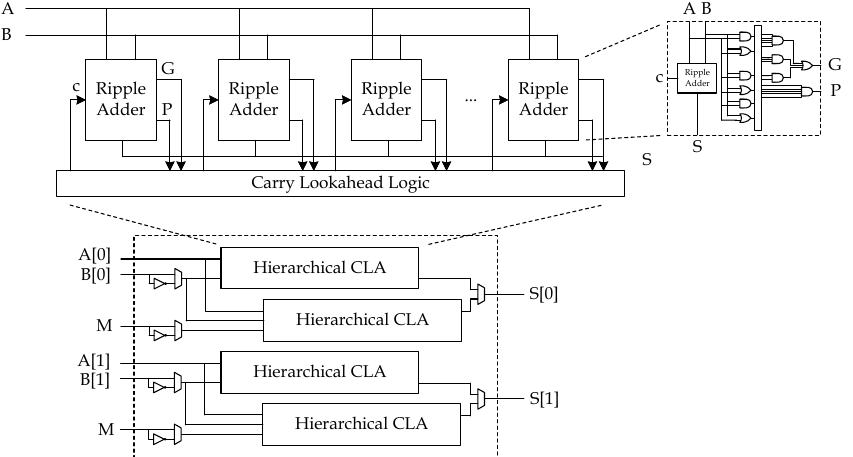
Figure 6. Schematic of quadratic field modular